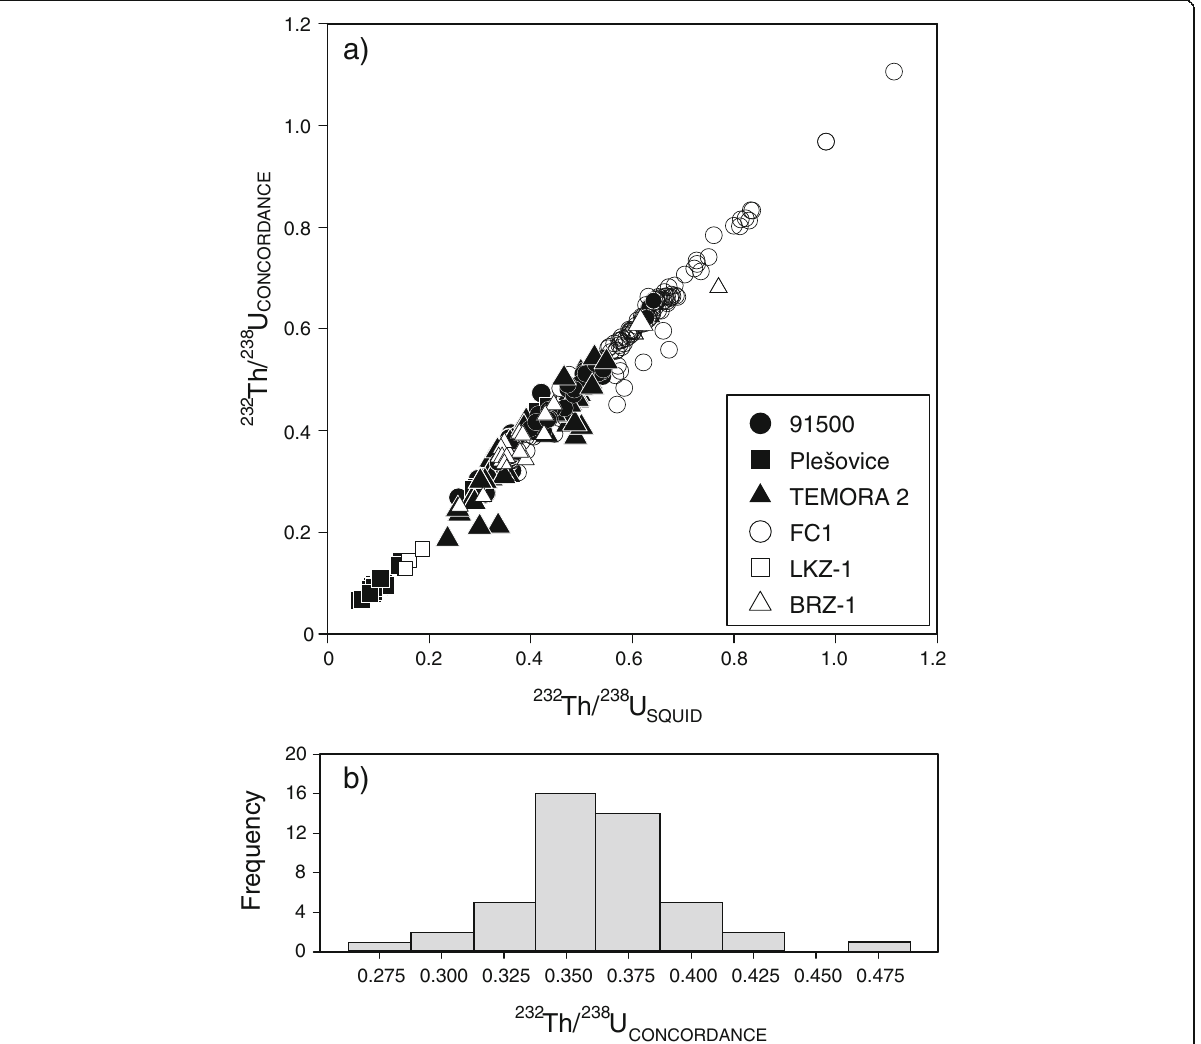
Fig. 3 a Comparison between 232 Th/ 238 U ratios calculated using SHRIMP 208 Pb/ 206 Pb data and the assumption that the U – Pb and Th – Pb isotopic systems in the zircons are concordant ( 232 Th/ 238 U CONCORDANCE ) and those calculated by the SQUID program ( 232 Th/ 238 U SQUID ). b The frequency histogram of 232 Th/ 238 U CONCORDANCE ratios for the 91500